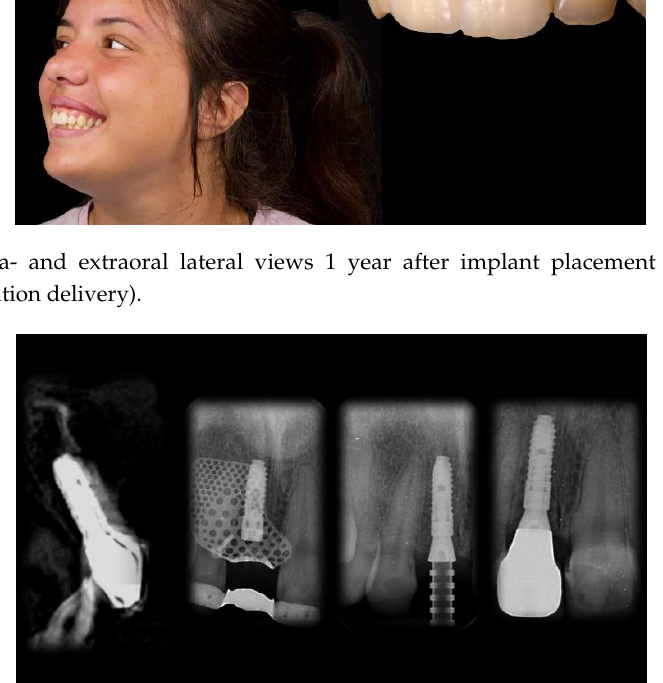
Figure 17. Sequence of radiographic examinations from implant placement to 1 year later.